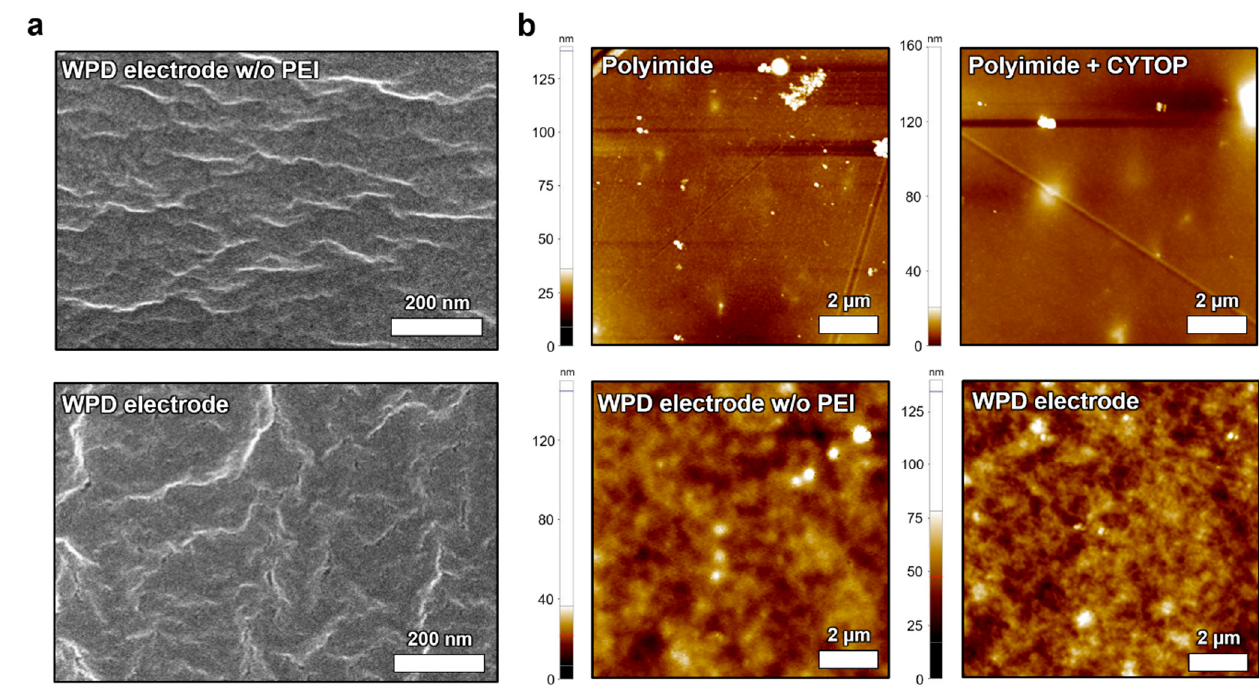
Figure 3. The morphological analysis of the WPD electrodes. The SEM surface image of ( a ) the WPD electrode layer without PEI and WPD electrode layer; the AFM surface image of ( b ) the PI substrate, CYTOP coated PI substrate, WPD electrode layer without PEI and WPD electrode layer.